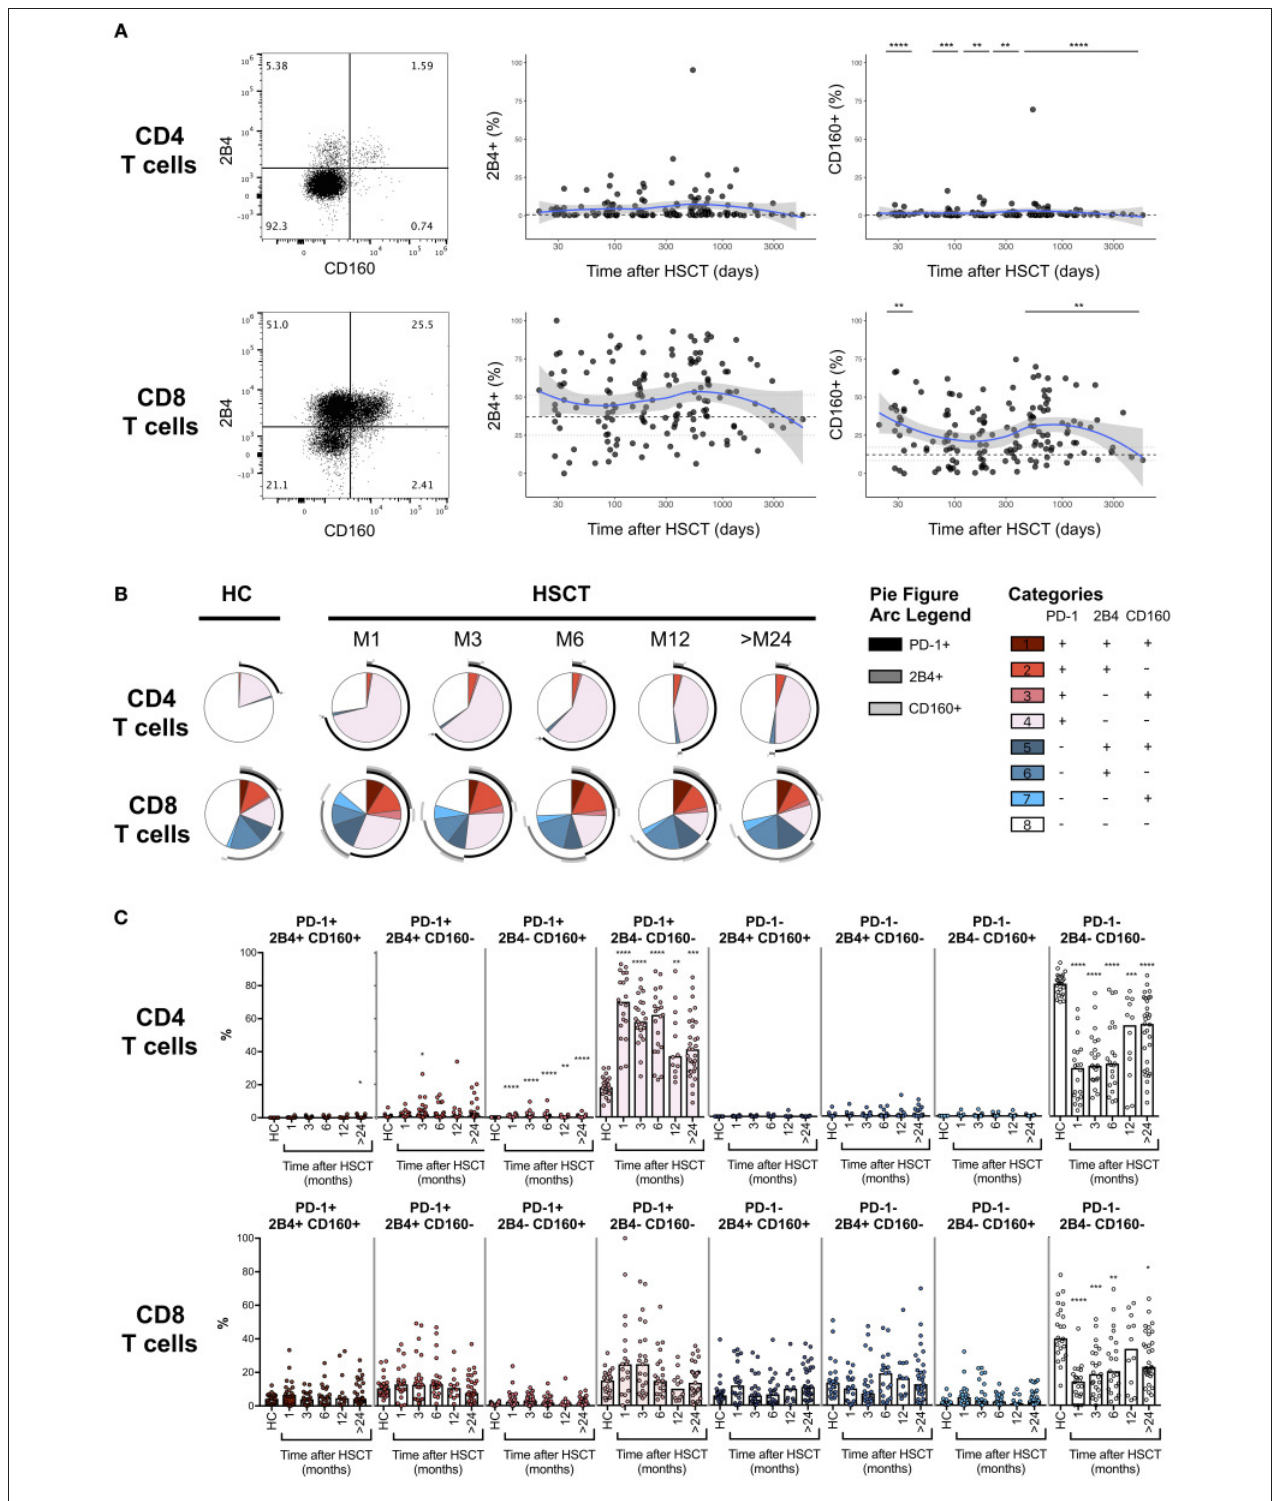
FIGURE 3 | Co-expression of PD-1, 2B4, and CD160 on CD4 and CD8T cells after allogeneic HSCT. (A) Representative dot plots (left panels) and proportions of 2B4 and CD160 expressing CD4 or CD8T cell subsets from HSCT recipients (black filled circles) and their relationship with time since HSCT. Blue lines represent medians and the gray area represents the confidence interval. Median (black dashed line), 25th and 75th percentiles (gray dotted lines) of 2B4 and CD160 expressing T cells